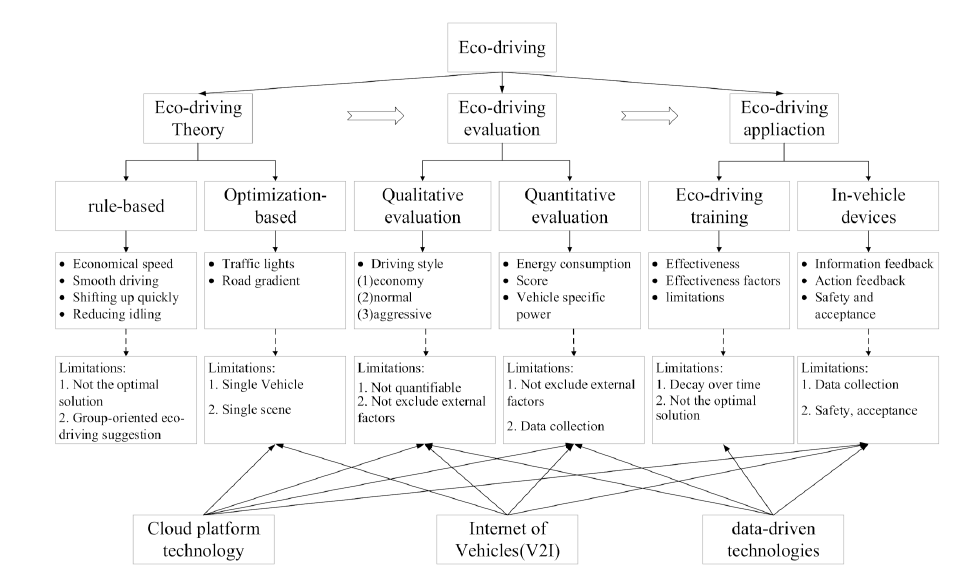
Figure 3. The overall framework of this